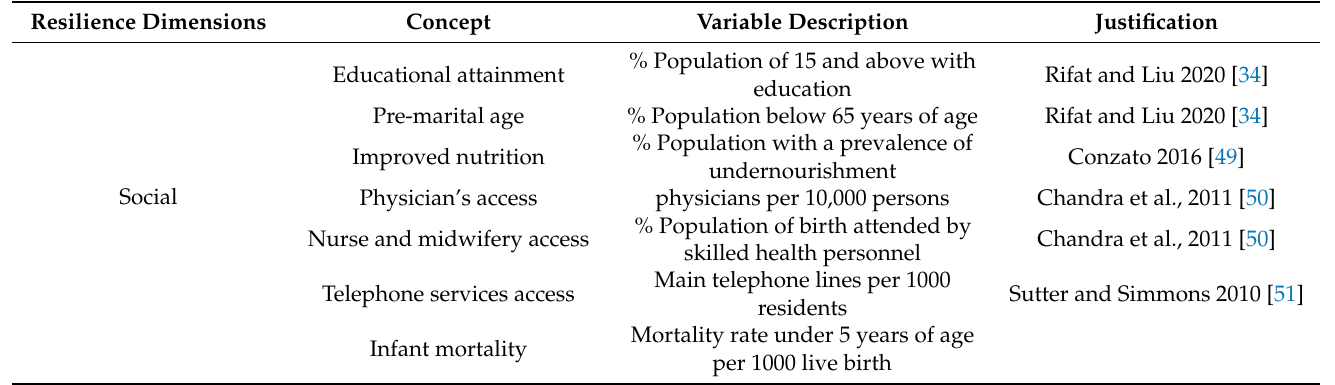
Table 1. Description and justification of resilience